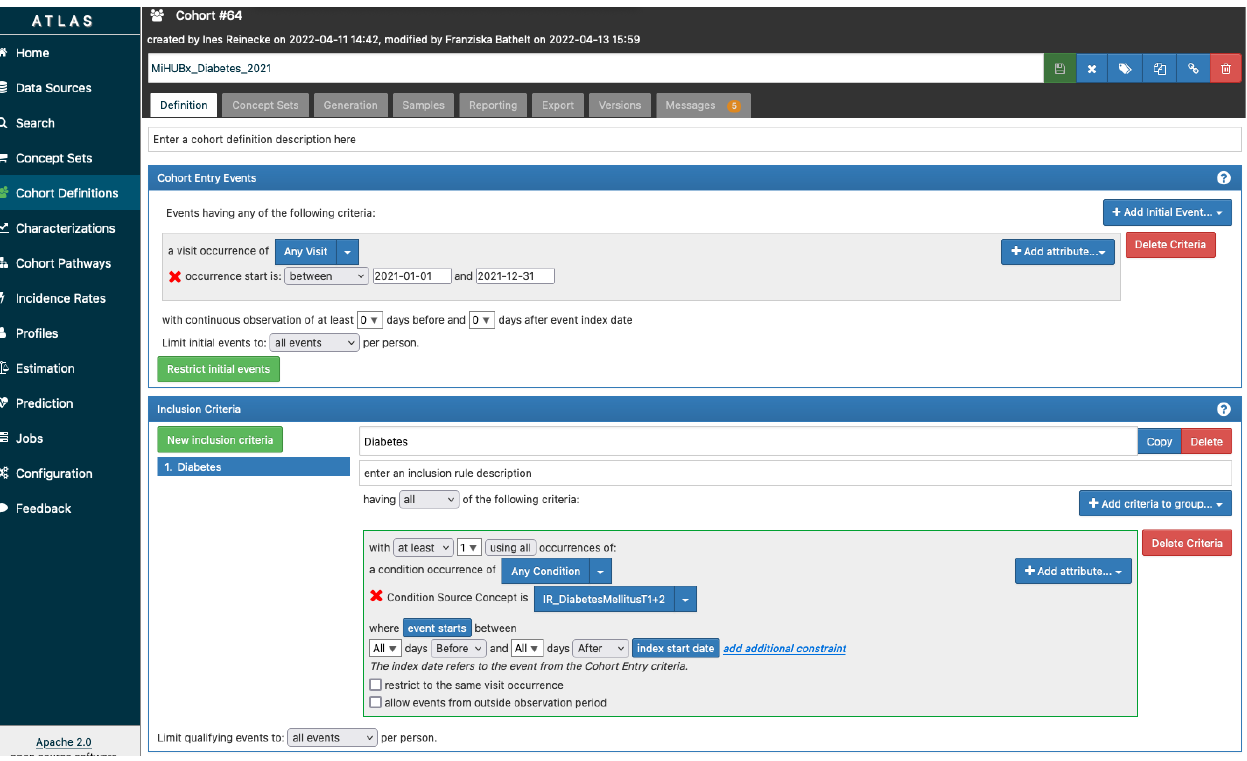
Figure A3. Interface of OHDSI ATLAS—Cohort Definition.